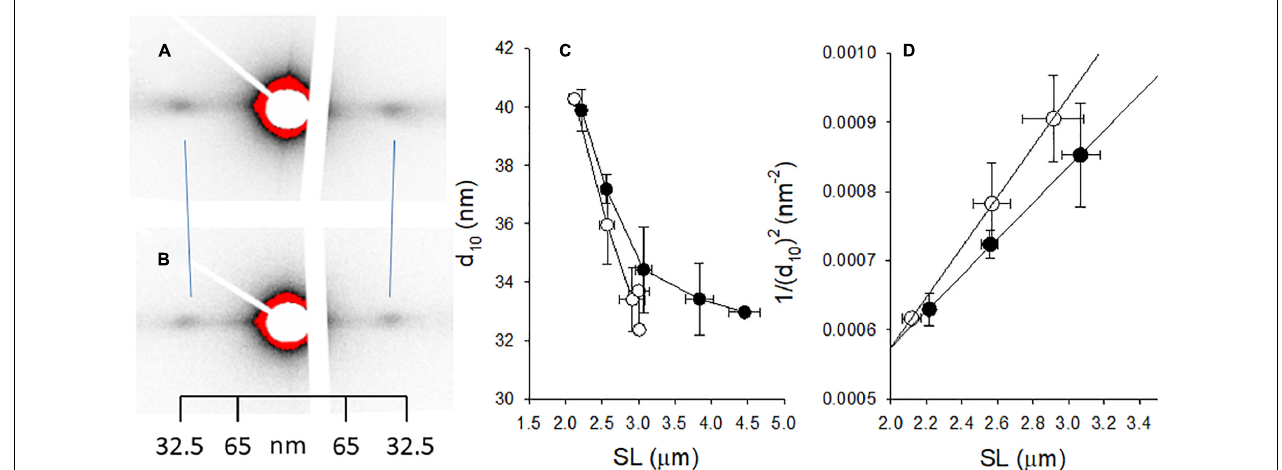
FIGURE 5 | Small angle x-ray scattering of muscle fibers from normal control [ (A) open symbols in (C,D) and woody breast] [ (B) filled symbols in (C,D) ]. (A,B) Show original recordings of x-ray patterns where the 1.0 equatorial reflections are indicated. Note inward movement of reflections in the woody breast group, showing wider lattice spacing. Calibration from collagen pattern is indicated. (C) Depicts the spacing of the 10 reflection (d 10 ) and in (D) the 1/(d 10 ) 2 is plotted against the sarcomere length (SL), with straight lines fitted to the data (the slope is inversely related to lattice volume, ref: Millman, 1998). The estimated lattice volumes were 3.18 × 10 - 3 and 4.42 × 10 - 3 µ m 3 in normal and woody breast groups, respectively. n =